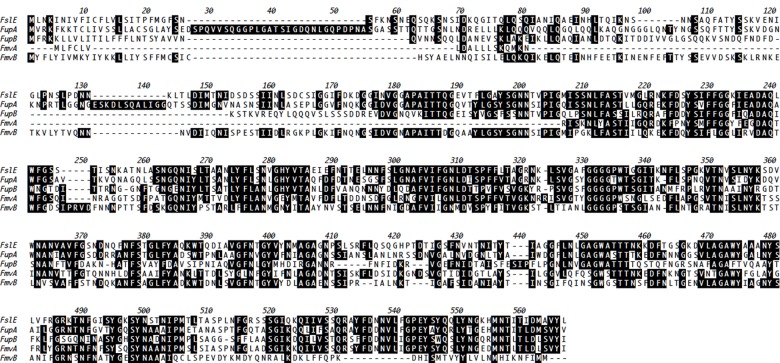
Amino acid alignment of FslE, FupA, FupB, FmvA, and FmvB.ClustalW amino acid sequence alignment for FslE (FTT0025c), FupA (FTT0918), FupB (FTT0919), FmvA (FTT0267), and FmvB (FTT0602c). Black boxes with white amino acid letters indicate conserved residues.